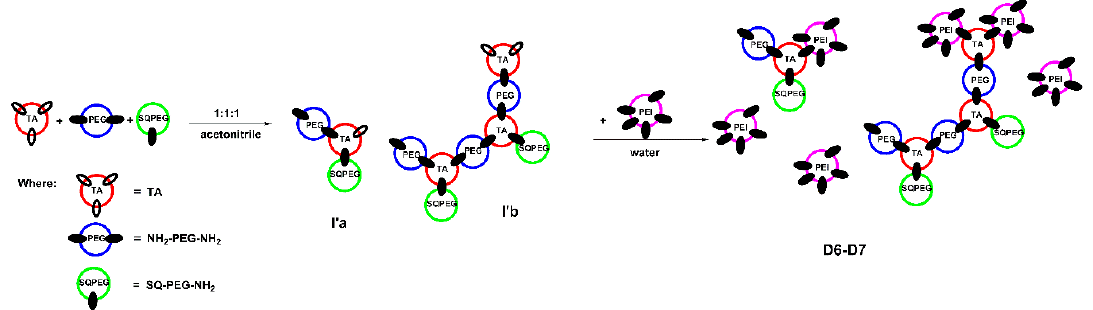
Figure 3. Schematic representation of the two-step synthesis of DCFs F6 and F7.